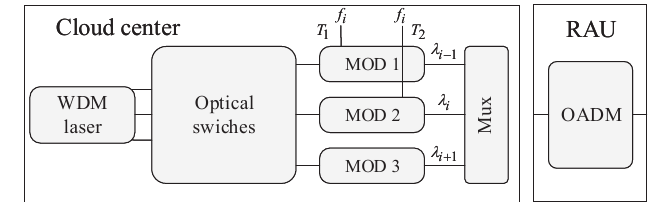
Figure 7. Basic architecture in the cloud processing center to implement moving cell [42].